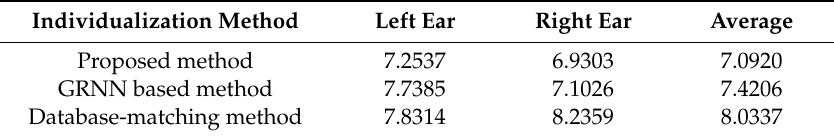
Table 3. Average spectral distortion between the synthesized and the measured HRTF